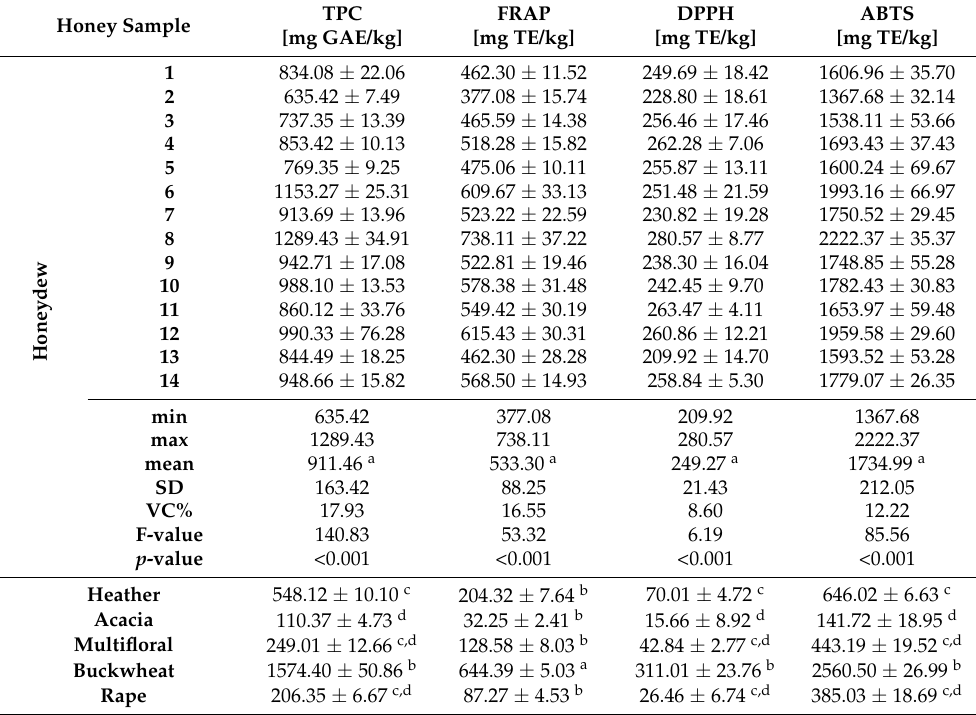
Table 3. Total phenolics content (TPC), reducing/antioxidant power (FRAP), and radical scavenging activity (DPPH and ABTS) of the analyzed honeys. TPC Honey Sample [mg